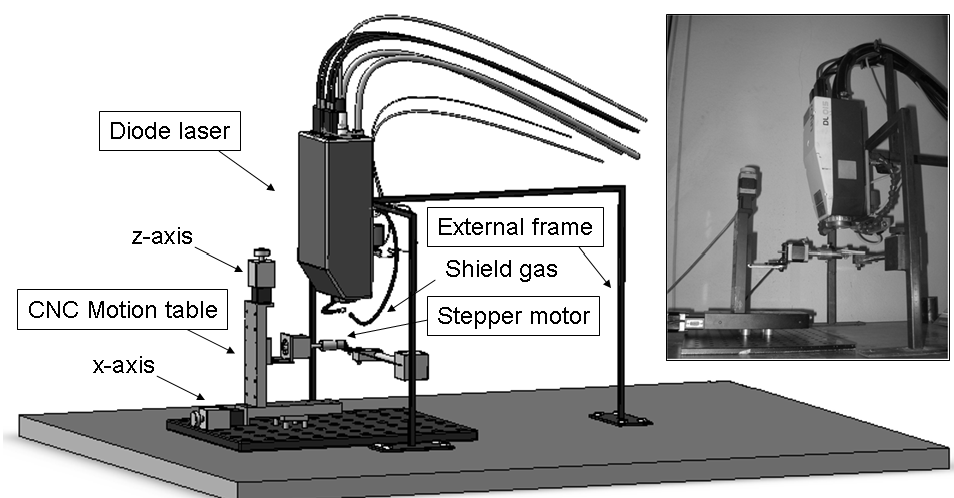
Figure 1. Experimental apparatus for laser-assisted winding of thermoplastic